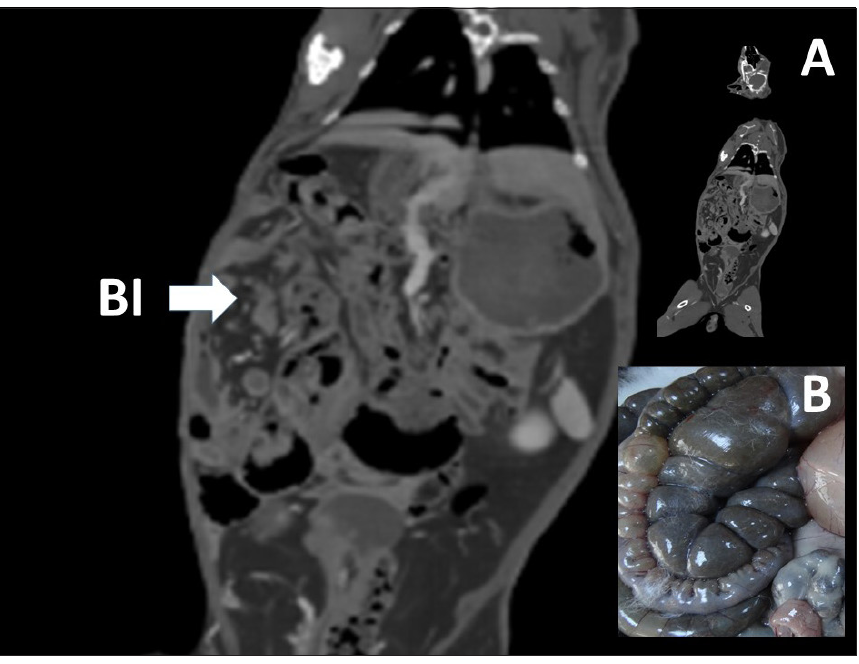
Figure 1. Computed tomography of the abdomen (A) showing dilated edematous intestinal wall and abdomino-peritoneal fluid collections (BI/Base)